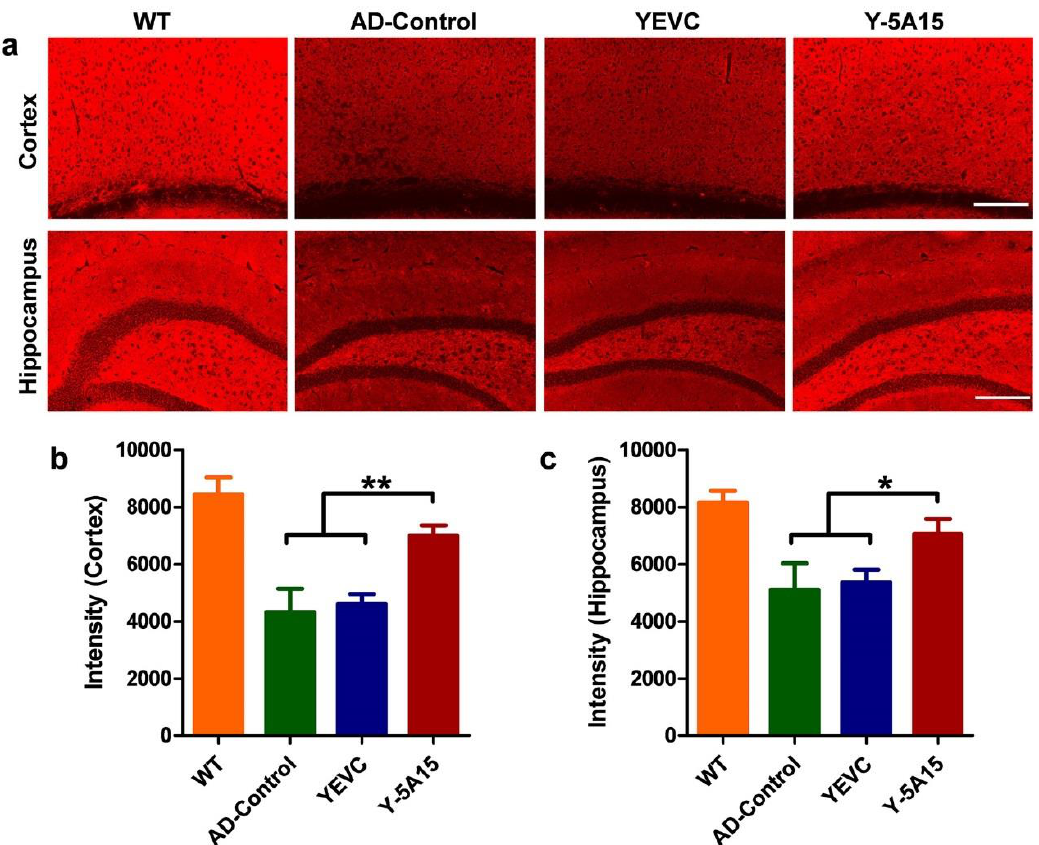
Figure 6. Active immunotherapy using Y-5A15 vaccine rescued synaptic deficits in APP / PS1 transgenic mice. ( a ) Presynapses in brains of mice were detected by IHC with anti-synaptophysin antibody in various immunized groups. Synaptophysin in the cortex and the hippocampal regions ( b , c ) was quantified using IPwin5 Image-Pro Plus software, respectively, and results are shown in arbitrary units (AU). * p < 0.05, ** p < 0.01. Scale bar is 200 μm.